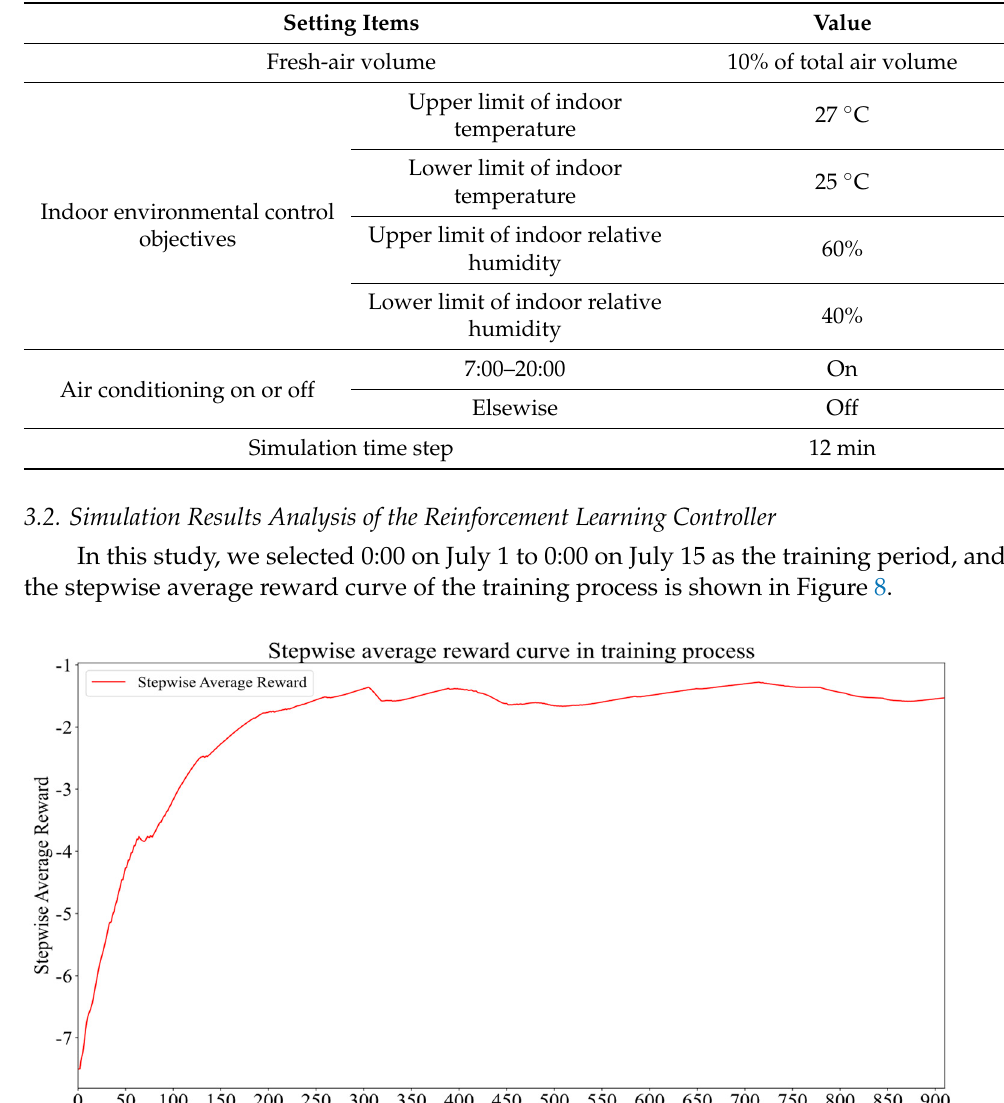
Table 7. Settings for the HVAC system.